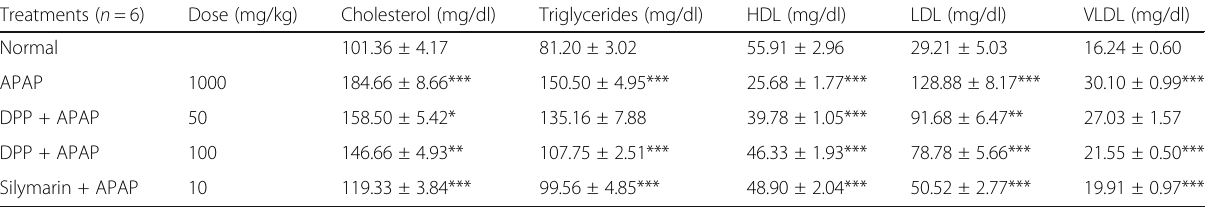
Table 2 Effect of DPP on APAP-intoxicated rats serum lipoproteins of control and experimental rats Treatments ( n = 6) Dose (mg/kg)